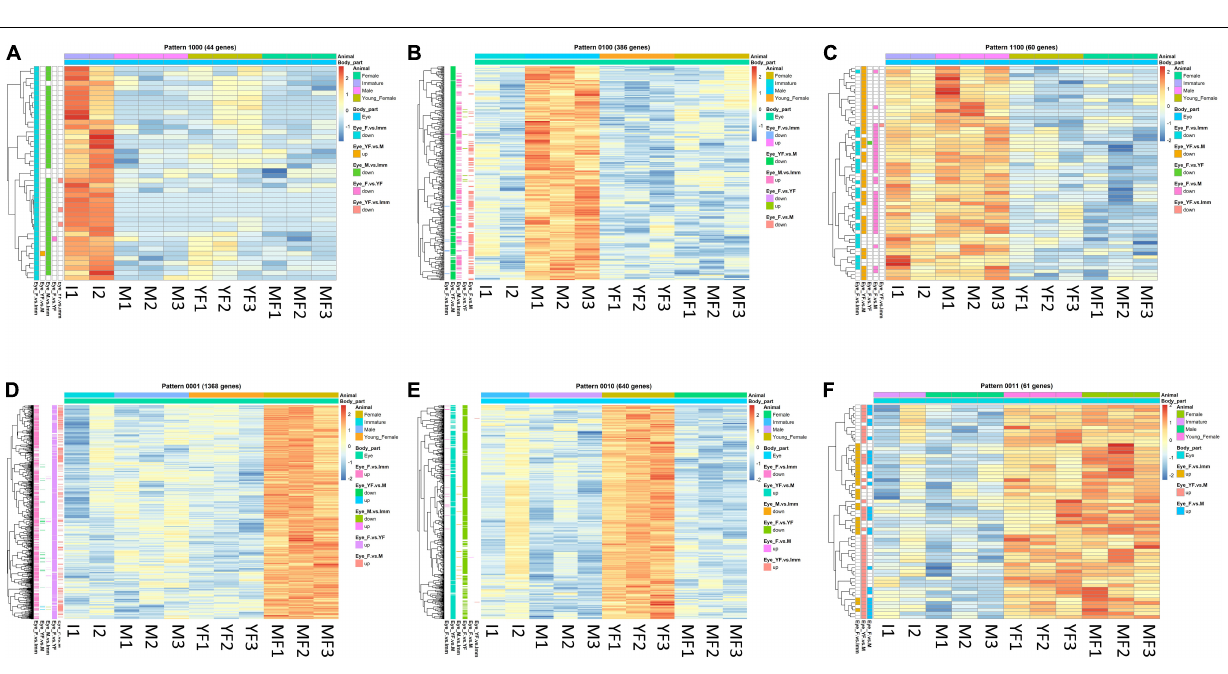
Frontiers in Marine Science |